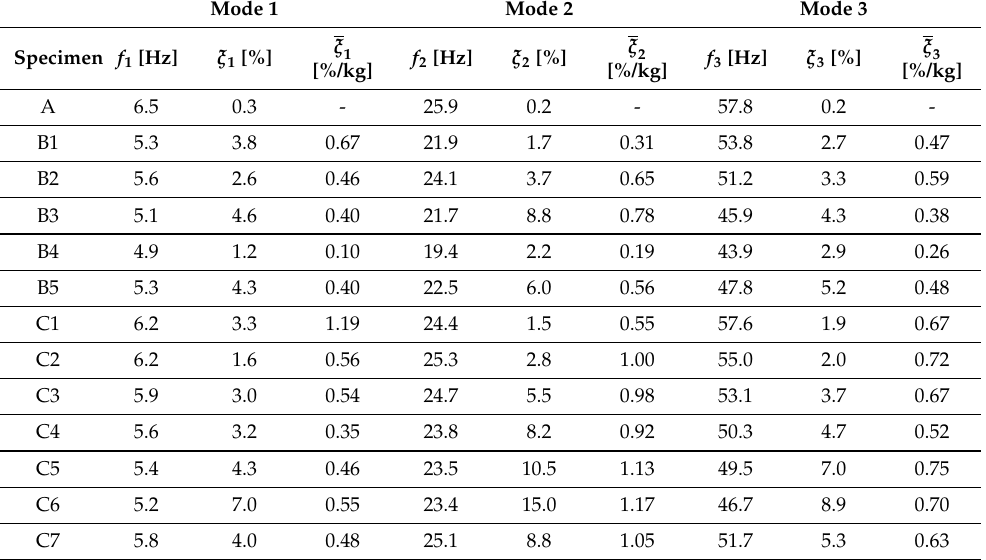
Table 2. Modal parameters (natural frequency and absolute and specific damping coefficient) for the first three mode shapes of the different configurations.